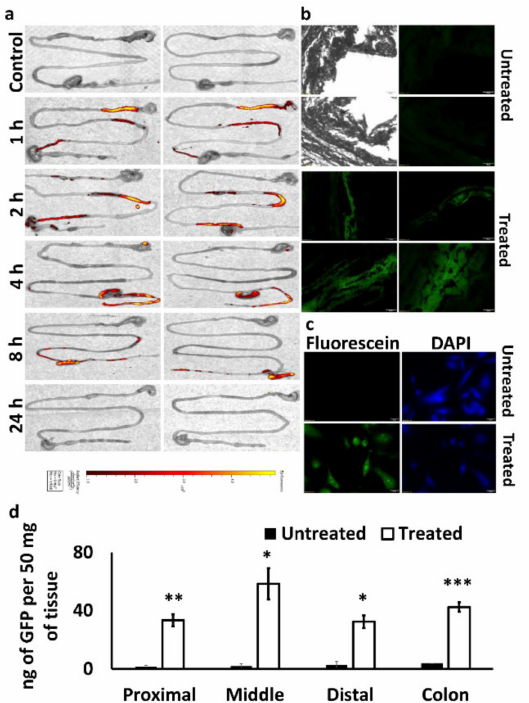
Figure 9. In vivo evaluation of PEG-PCL NPs with encapsulated Man-PEI/plasmid complexes, following oral administration. ( a ) Ex vivo imaging of the biodistribution of fluorescently-labeled PEG-PCL NPs in the intestinal tract of mice ( n = 2) following their oral administration; ( b ) fluorescence imaging of cryosections from the intestinal tract of mice without any treatment (upper 4 images; the two on the left are bright-field images of the respective spots in the two right Fluorescein images) and mice that were treated with GFP-expressing plasmid complexed with Man-PEI and encapsulated in PEG-PCL NPs; ( c ) SW480 cells were incubated with GFP-expressing plasmid and lipofectamine that served as a positive control for the GFP expression; ( d ) GFP quantification in intestinal tissues obtained from untreated (control mice) and treated (mice treated with GFP-expressing plasmid/Man- PEI complexes in PEG-PCL NPs; see Method section) groups. *** p < 0.001 ** p < 0.01 * p < 0.05 using two-tailed t